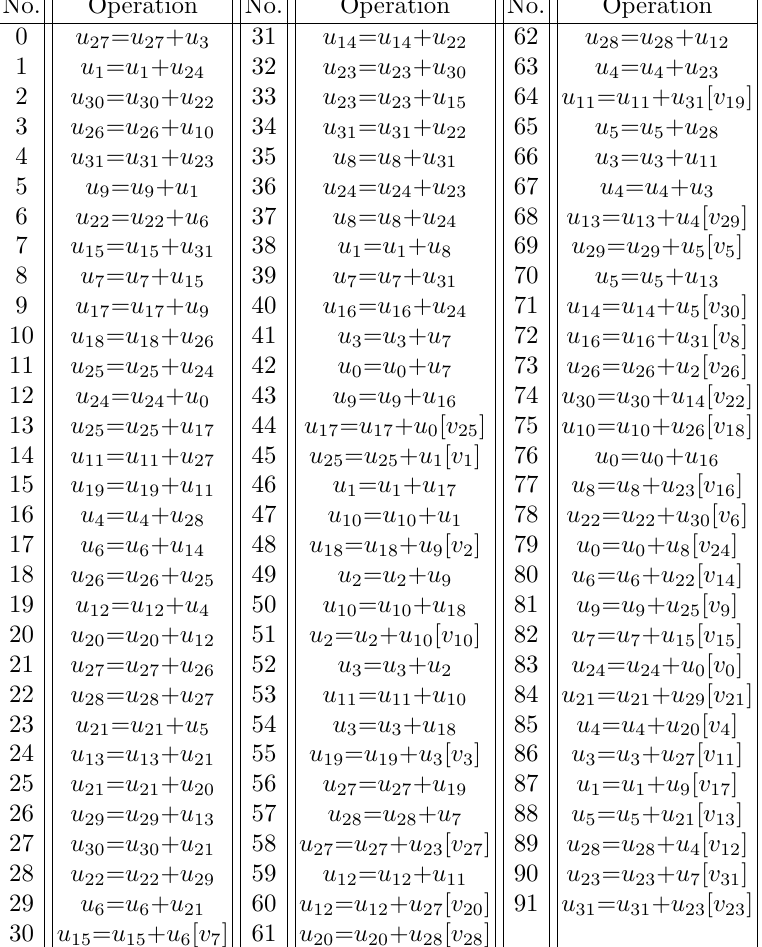
Table 4: An implementation of AES inverse MixColumns with 92 Xor